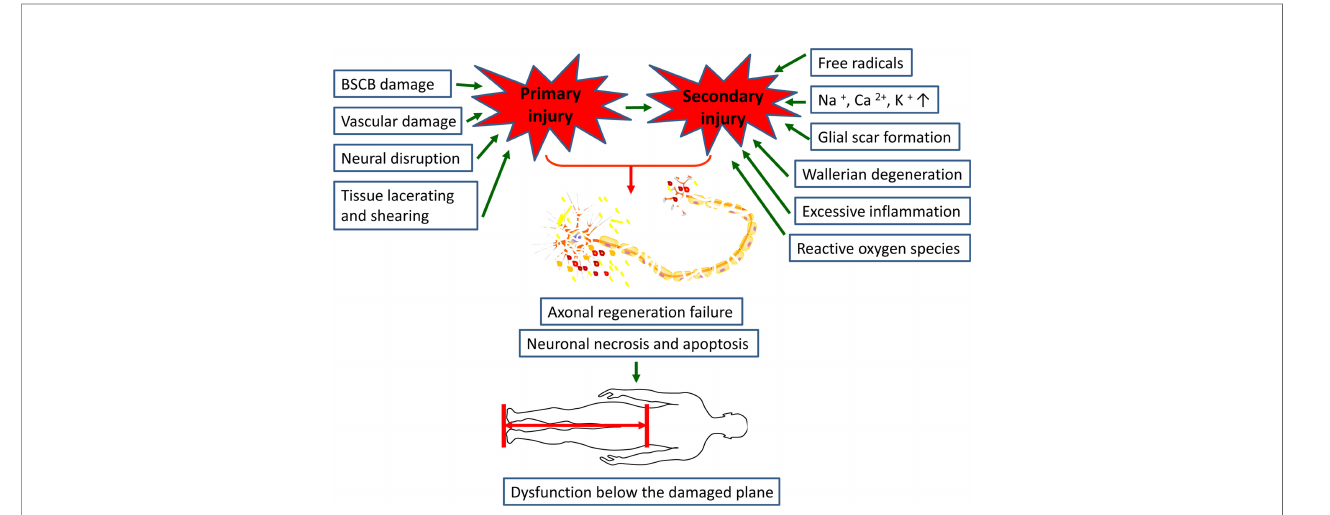
FIGURE 1 | Primary and secondary injuries together leading to axonal regeneration failure and neuronal necrosis and apoptosis, results in dysfunction below the damaged plane in SCI